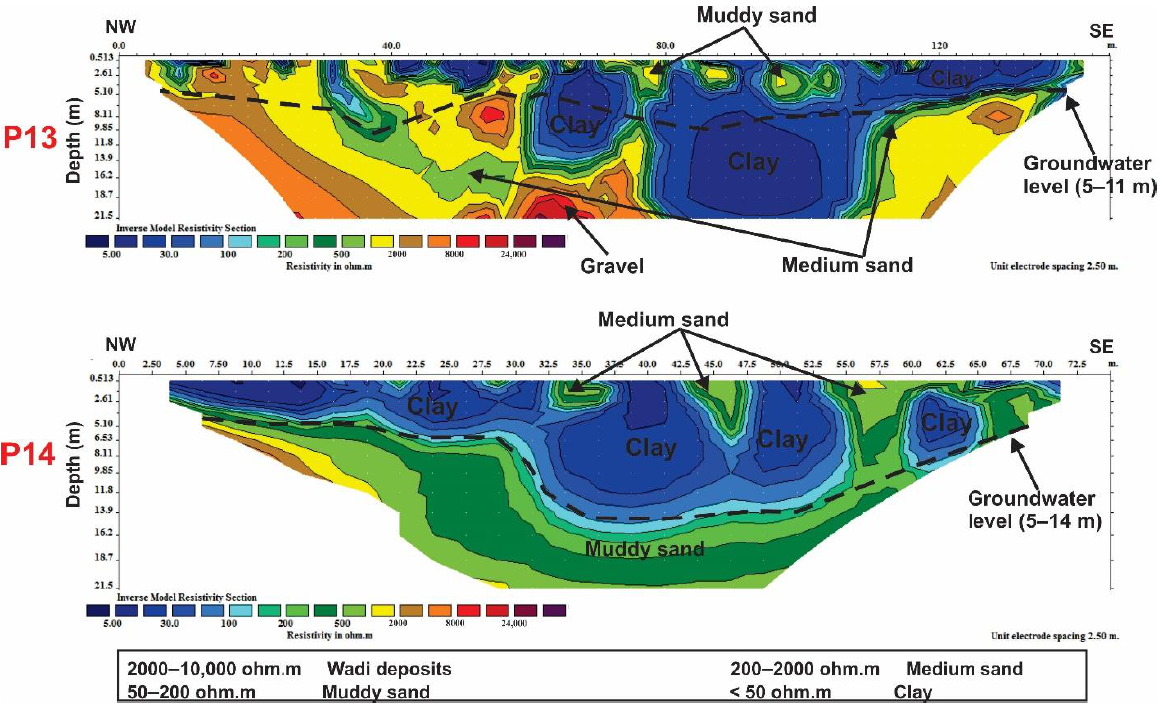
Figure 8. Interpreted 2D inverted resistivity model of profiles 13 – 14. According to the resistivity values, four difference geoelectric zones were recognized. These zones are: (1) wadi deposits, which are mainly composed of gravels, sands, and silts; (2) medium sand deposits; (3) muddy sand deposits; and (4) clay deposits.